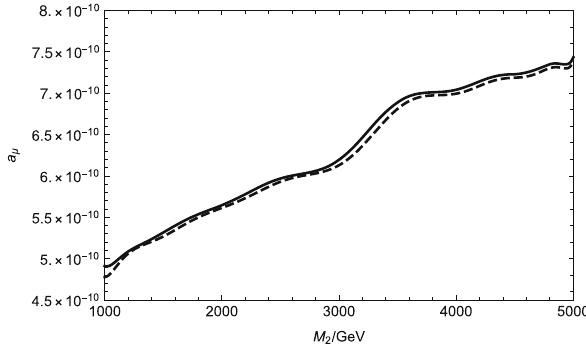
Fig. 6 The relationship between a μ and M E 11 = M E 22 = M E 33 = M E . The dashed line expresses M 2 = 1000 GeV, and the solid line expresses M 2 = 800 GeV almost horizontal and about 5 . 0 × 10 − 10 . The smallest value